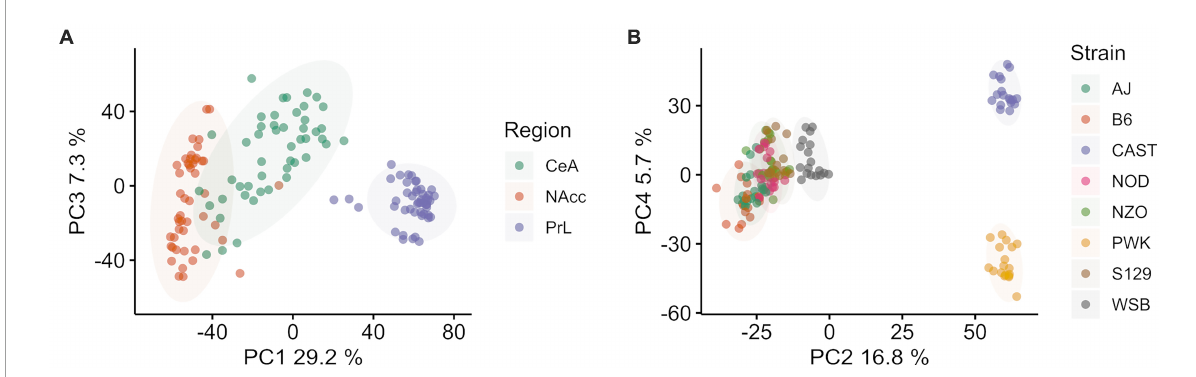
FIGURE1 Principal component (PC) analysis of Collaborative Cross founder strains colored by brain region (left, A ) and strain (right B ). (A) Principal component 1 vs. 3 colored by brain region shows ∼ 40.1% of total explained variance is associated with brain region. The prelimbic cortex (PrL) is separated from the central nucleus of the amygdala (CeA) and the nucleus accumbens core (NAcc) (B) Principal component 2 vs. 4 colored by strain shows ∼ 37.1% of total explained variance is associated with strain. Wild-derived strains PWK and CAST are isolated in both PC2 and PC4, while WSB and classical inbred laboratory strains are clustered in the middle. Wild-derived strain names are colored purple for clarity. Ellipses represent the 90% confidence interval for each group, assuming a multivariate normal distribution, and are intended as a visual guide.